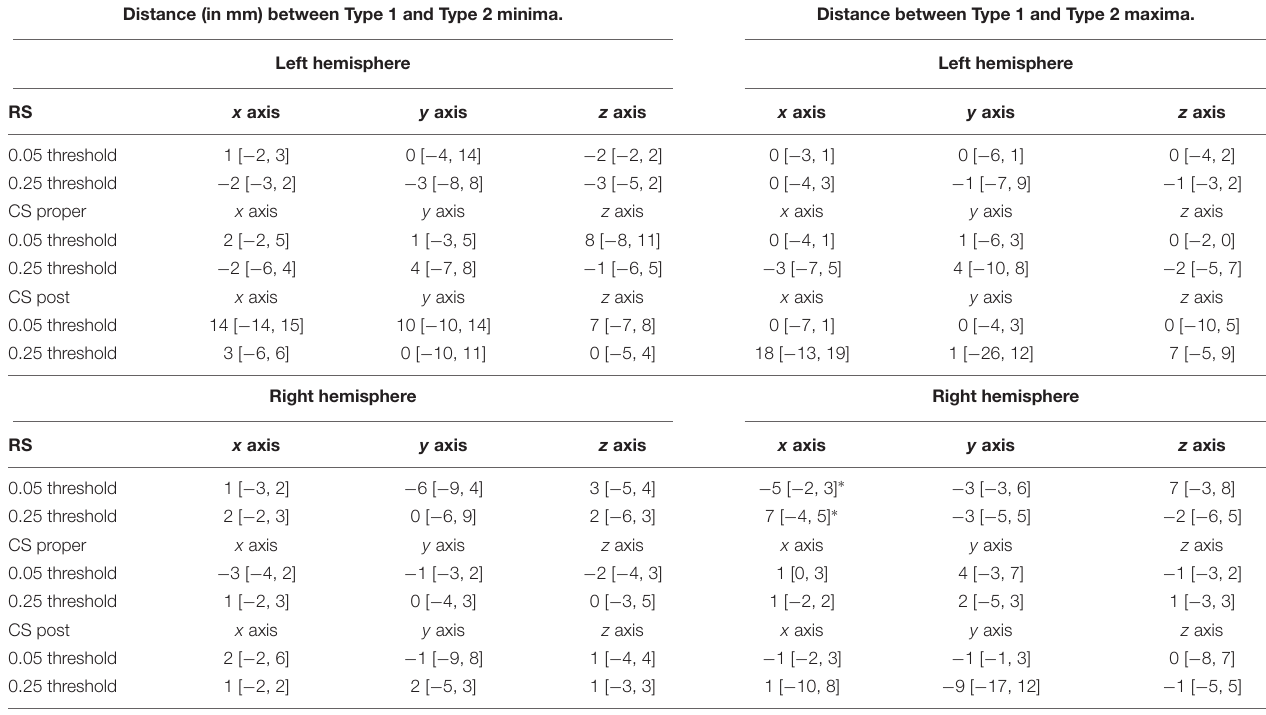
TABLE 2 | Distance between the minima and maxima of Type 1 and Type 2 for each sulcus, for two different thresholds. Distance (in mm) between Type 1 and Type 2 minima. Distance between Type 1 and Type 2